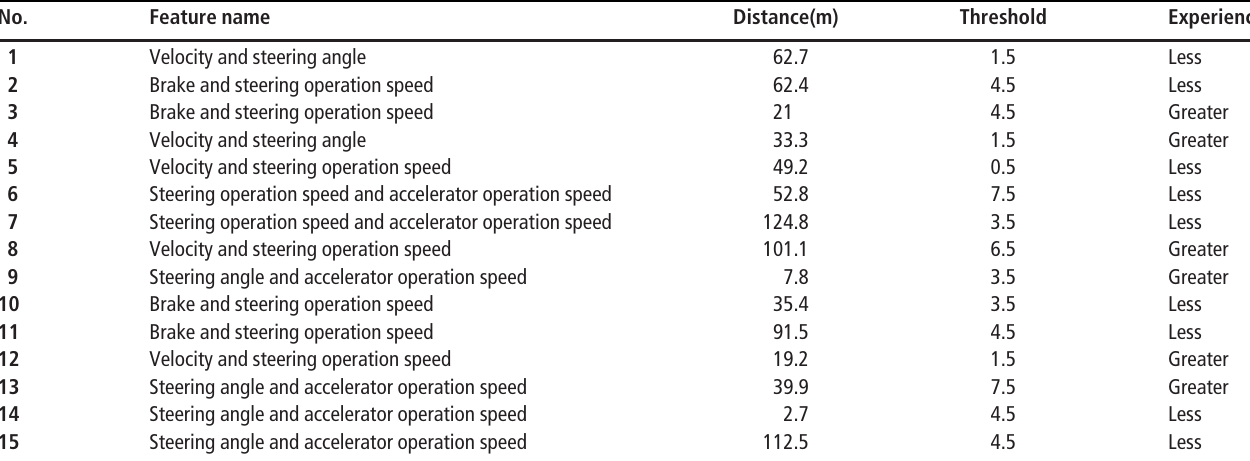
Table III Basic information of features extracted at 1-th curve No.